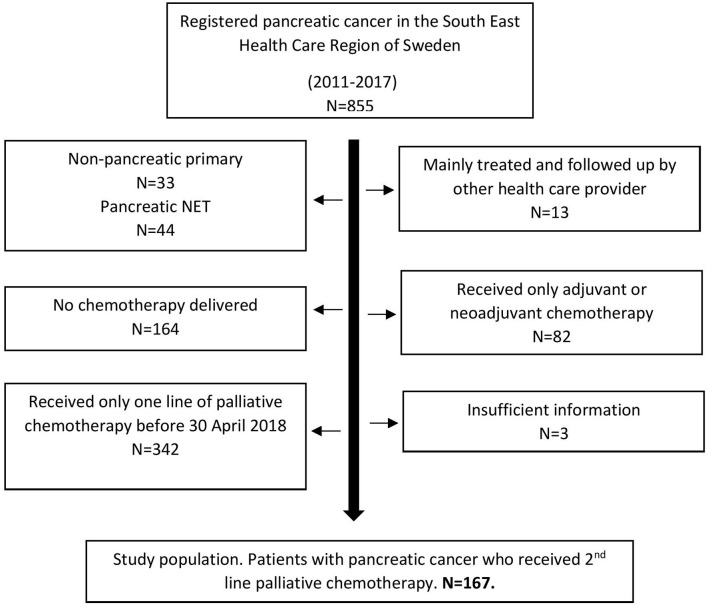
Flow chart study population. NET, Neuroendocrine tumor.